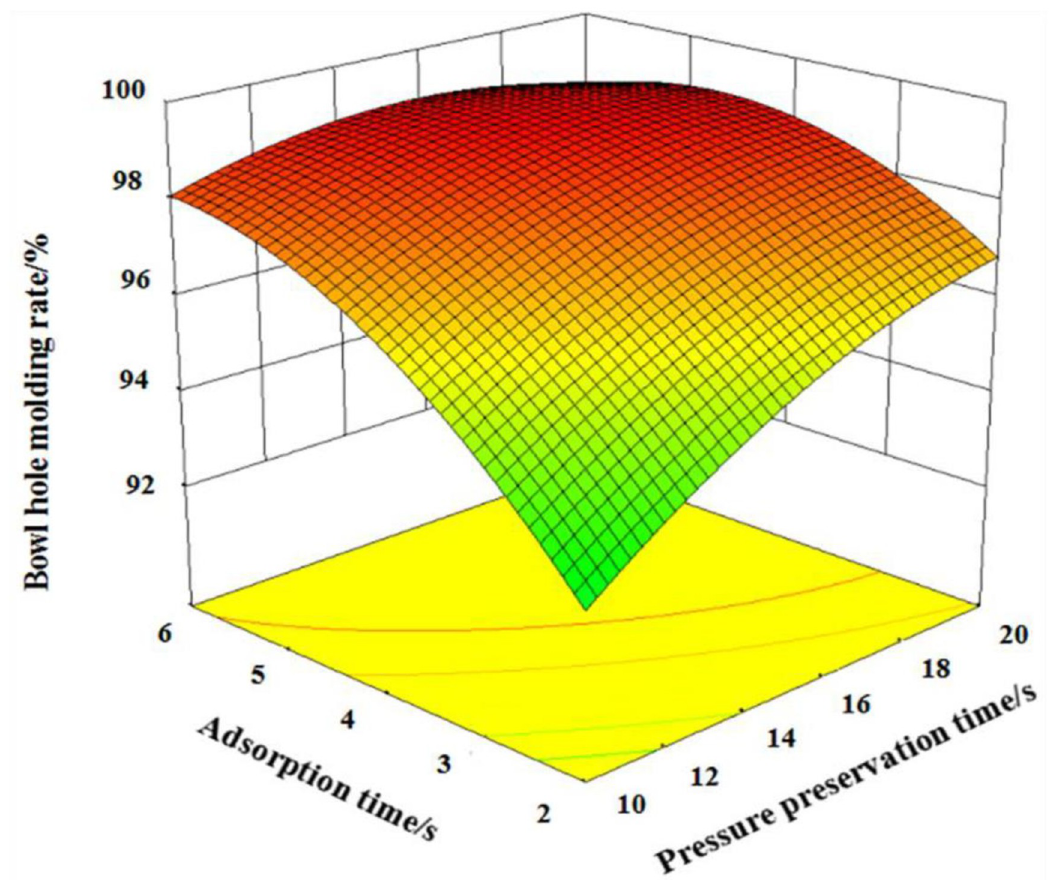
Fig 8. The interaction of the pressure preservation time and adsorption time on the bowl hole molding rate.